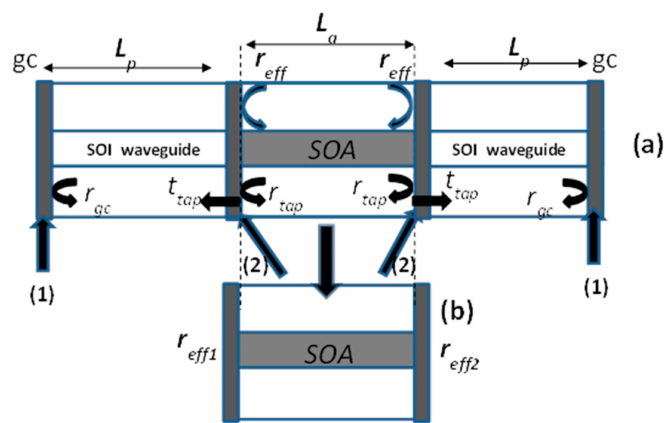
Figure 5. ( a ) Multi-section cavity model; (1): input grating couplers (GC) equivalent mirror (2): silicon on insulator (SOI)–SOA taper section ( b ) equivalent